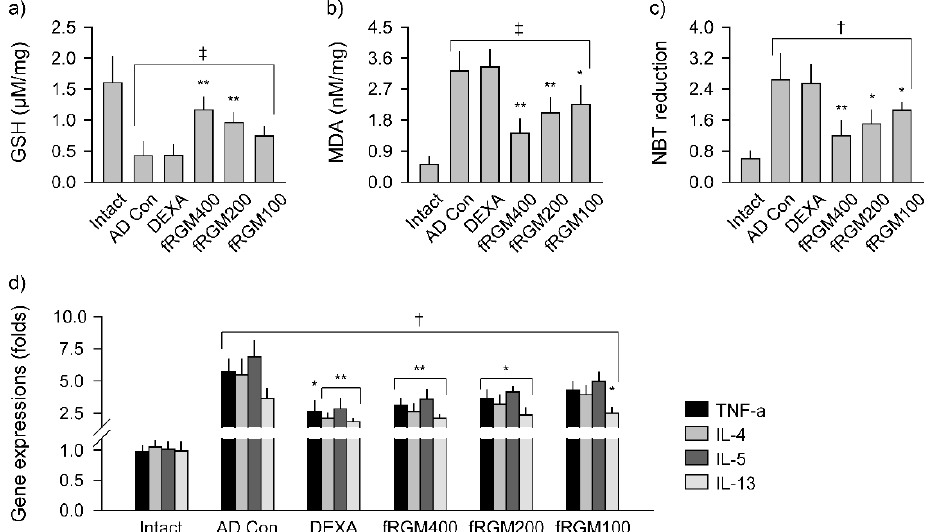
Figure 2. Effects on antioxidant activities and production of inflammatory mediators in skin lesions. ( a – c ) Levels of glutathione (GSH), malondialdehyde (MDA), and nitroblue tetrazolium (NBT) reduction. ( d ) Relative mRNA expressions for tumor necrosis factor (TNF)- α, interleukin (IL)-4, IL-5, and IL-13 to GAPDH in the skin lesion. Values are represented as means ± SDs. ‡: p < 0.01 and †: p < 0.05 vs. the Intact group; **: p < 0.01 and *: p < 0.05 vs. AD Con.